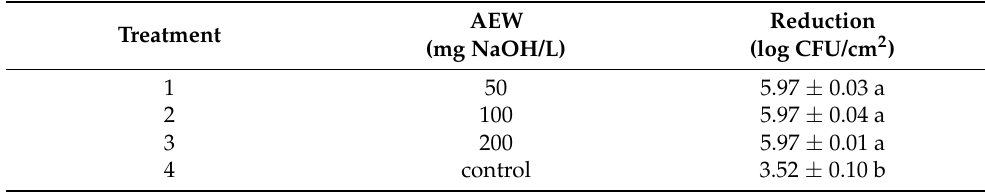
Table 7. Unifactorial design of AEW as cleaning agent, for 10 min at 30 ◦ C. Treatment